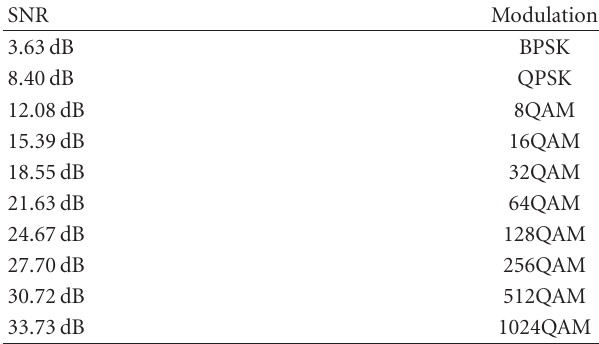
Table 1: Required SNR for di ff erent modulation levels.